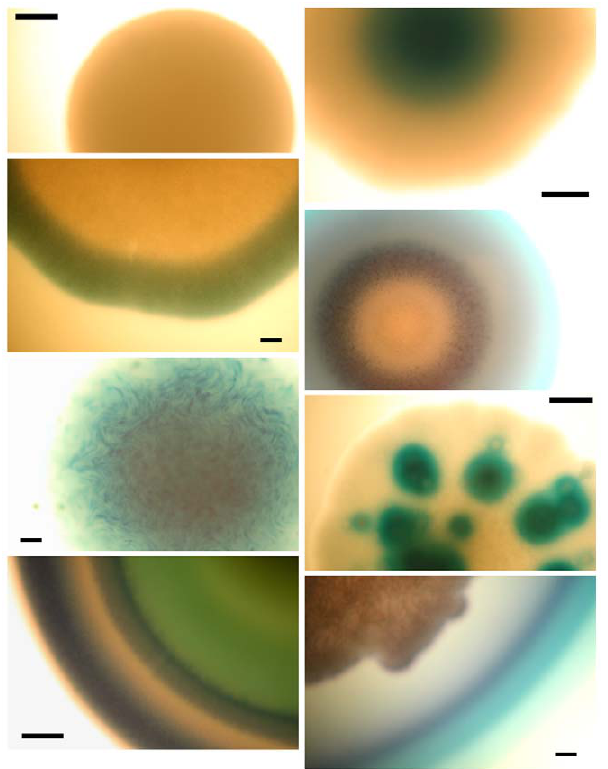
Figure 3. Details of colonies selected for isolates. Light micrographs of selected colony phenotypes growing on mBH2 medium with glucose and mannose as carbon sources, including H 2 O 2 -negative (top left), and various H 2 O 2 -positive phenotypes, allowing for selection of a wide diversity of phenotypes. Bar=100 m m.